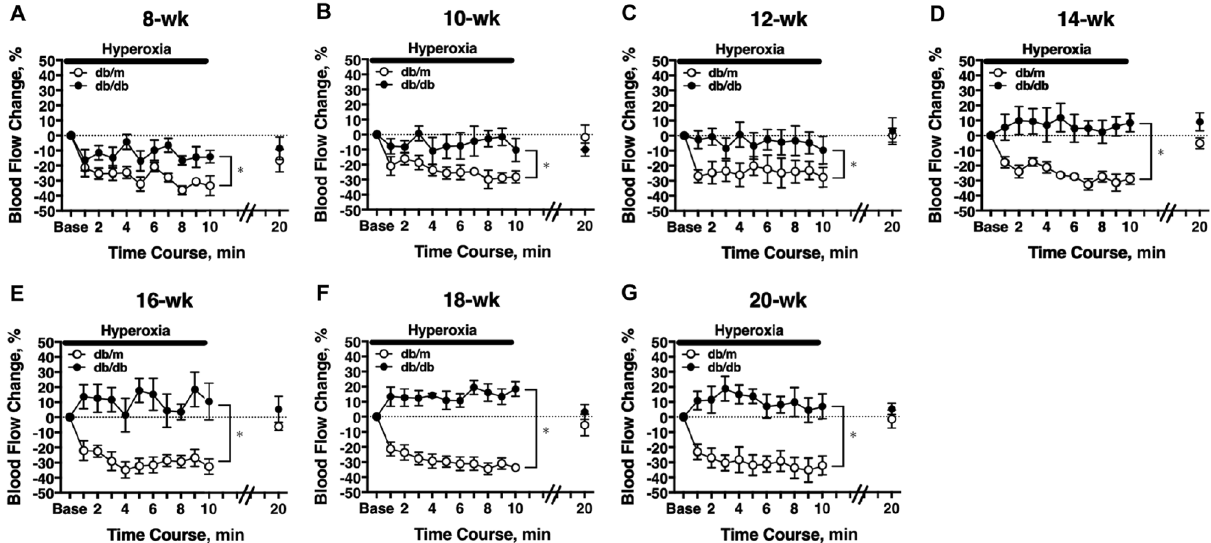
Figure 3. Retinal blood flow response to systemic hyperoxia. Longitudinal assessment of retinal blood flow in db/db and db/m mice from 8 to 20 weeks old. Retinal blood flow was significantly reduced from baseline during hyperoxia in db/m control mice (n = 6) from 8 weeks ( A ) to 20 weeks ( G ) of age. Reduction of retinal blood flow from baseline was observed in 8-week old db/db mice (A). No significant changes in retinal blood flow were noted in db/db mice (n = 6) at 10 weeks ( B ) and older ( C – G ) (one-way repeated measures ANOVA). The hyperoxia-induced flow response was significantly blunted in db/db mice for each age studied (two-way repeated-measures ANOVA). Following termination of hyperoxia, return of retinal blood flow to baseline levels occurred within 10 min, and no difference was observed between groups (two-way repeated measures ANOVA). *P < 0.05 between groups; Solid bar = period of